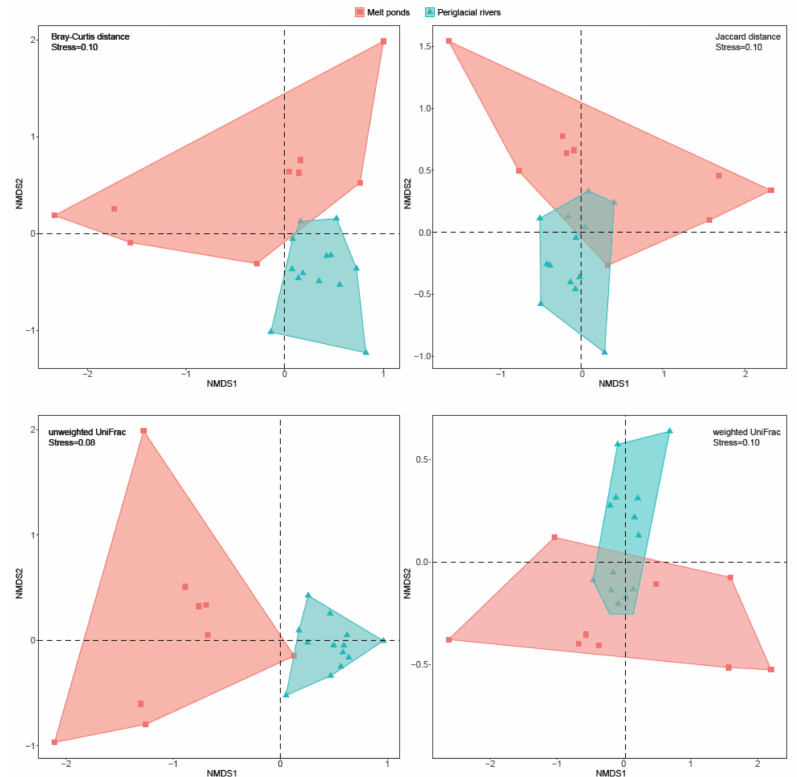
Figure 4. Non-metric multidimensional scaling (NMDS) plots of bacterial communities in melt ponds and periglacial rivers based on four distance matrices.